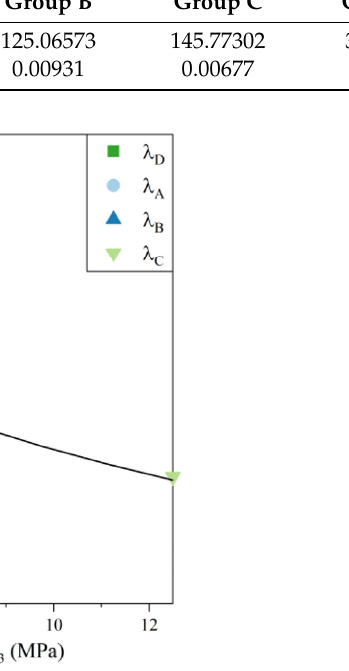
Figure 13. The relationship between the unloading residual confining pressure and the decay con- stant.